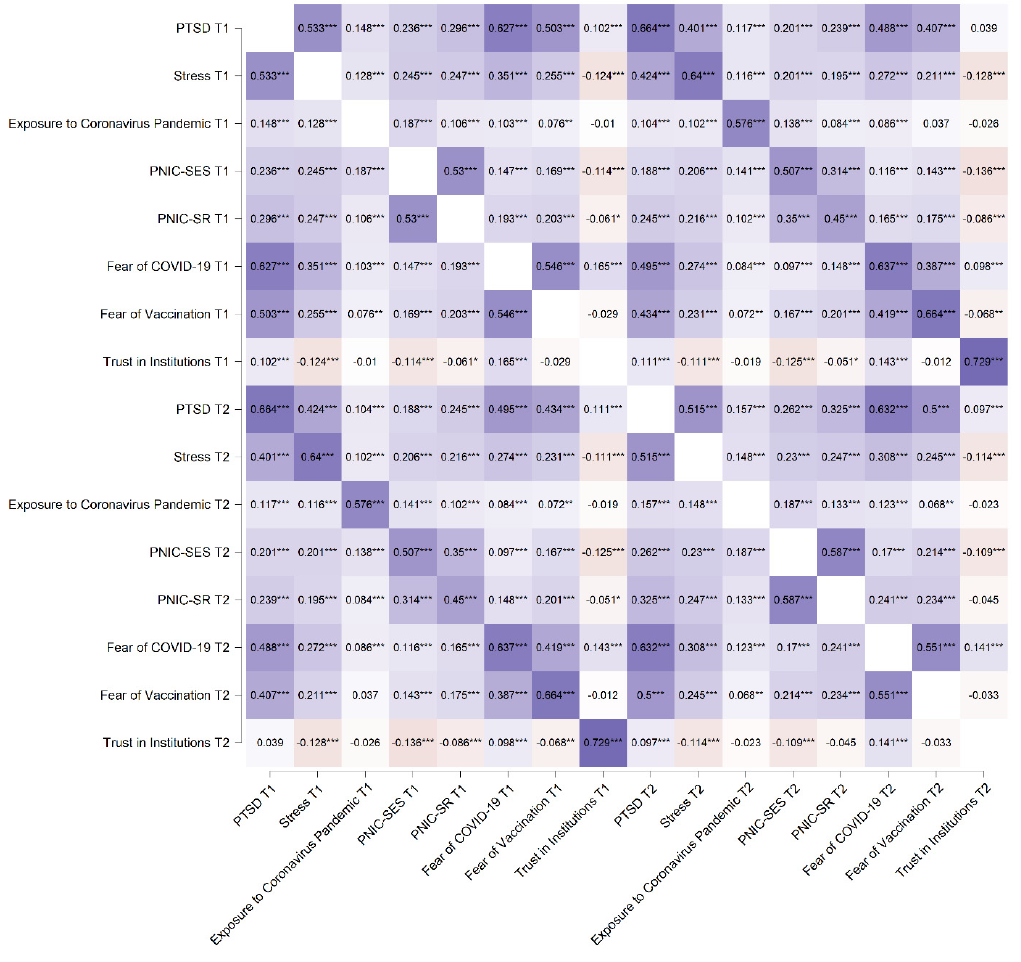
Figure 1. Pearson’s r heatmap. N = 1723; T1 = time 1 of measurement; T2 = time 2 of measurement; PNIC-SES = perceived negative impact of coronavirus–socioeconomic status; PNIC-SR = perceived negative impact of coronavirus–social relationships. Colors in shades of purple represent positive correlations, while colors in beige negative correlations. The most intense shades of colors represent a large effect size, while the lightest shades - a small effect size. * p < 0.05, ** p < 0.01, and *** p < 0.001. Almost all of the variables were correlated with weak-to-moderate strength. Corona- virus-related PTSD at T1 was strongly correlated to stress, fear of COVID-19, fear of vac- cination at T1 and coronavirus-related PTSD at T2. On the other hand, PTSD at T2 was additionally strongly correlated to stress, fear of COVID-19, fear of vaccination at T2. Most other variables were positively correlated. In contrast, higher trust in institu- tions was associated with lower stress, exposure to COVID-19, PNIC-SES, PNIC-SR, and fear of vaccination. However, higher trust in institutions was also related to higher coro- navirus-related PTSD and higher fear of COVID-19. 3.2.2. Change Model and Predictors of PTSD at T2 We conducted SEM to examine associations between variables at T1 and T2. The con- ceptual lagged regression model is presented in Figure 2.